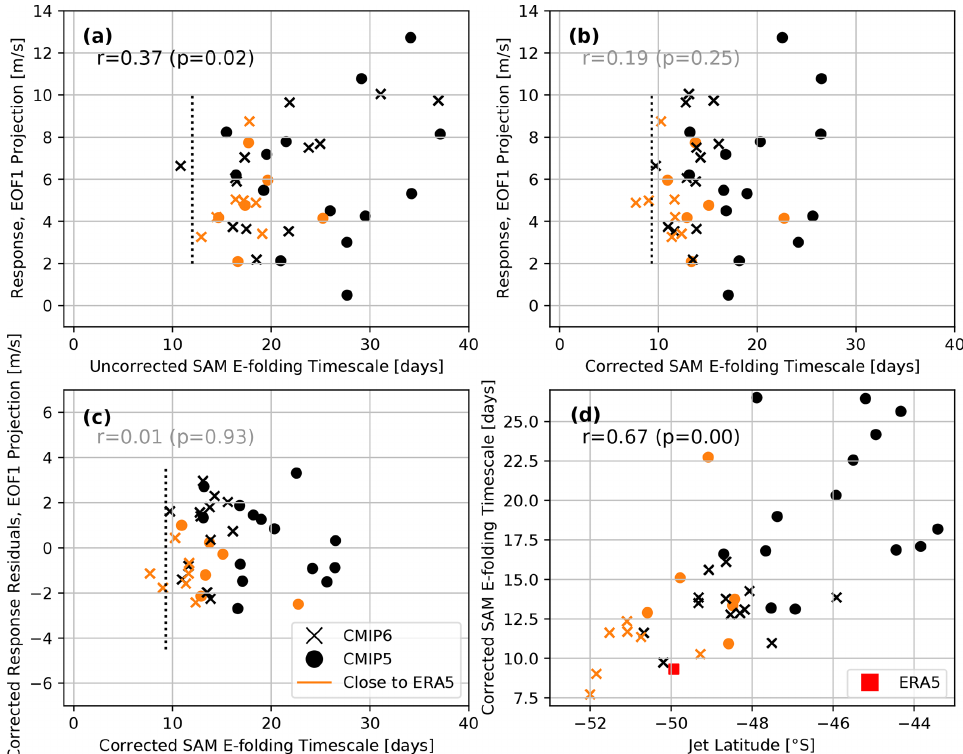
Figure 7. (a) CMIP5 and CMIP6 850hPa zonal wind response in DJF, projected onto EOF1, plotted against SAM timescale. (b) As in panel (a) , but after the VB influence has been regressed out of the SAM timescale. (c) As in panel (b) , but the impacts of the stratospheric VB response and differences in global warming have been regressed out of the EOF1 response (see text for details). (d) Corrected SAM timescale plotted against climatological jet position. Orange symbols denote models whose climatological jet latitude never deviates further than 5 ◦ from ERA5 over the year, while vertical dotted lines show the ERA5 DJF SAM timescale. Correlations with p > 0 . 05 are greyed